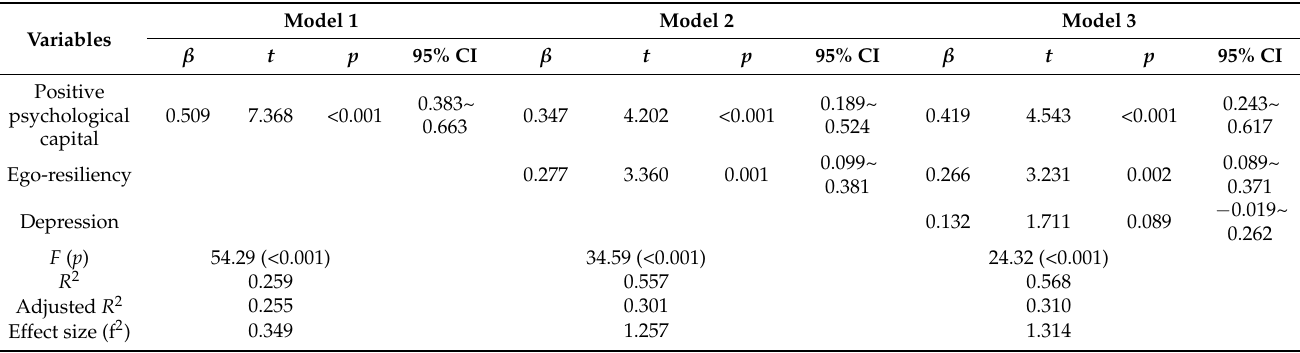
Table 3. Hierarchical multiple regression of person-centered care competence ( n =